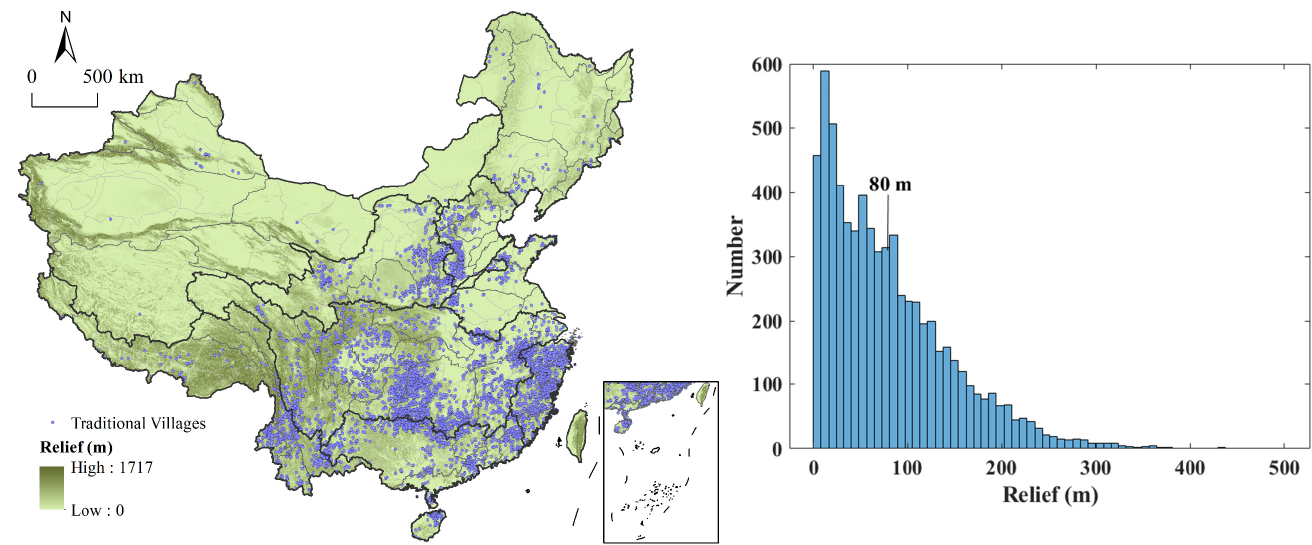
Figure 10. Relationships between traditional villages and topography relief in China.